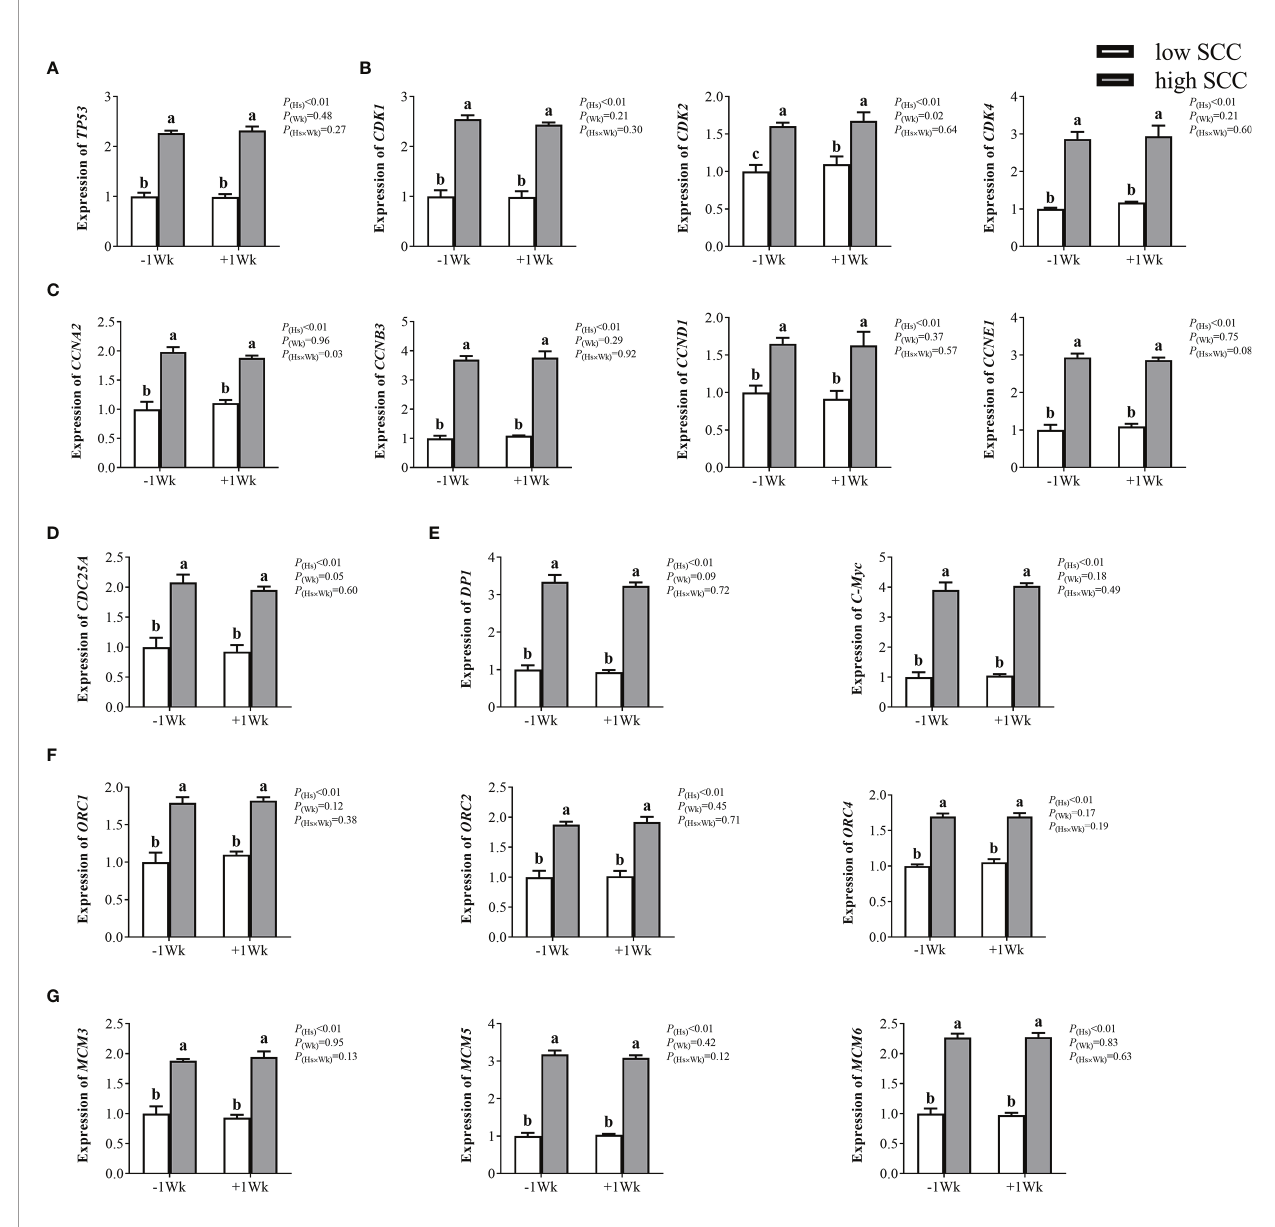
FIGURE 2 | The mRNA expression of genes involved in the cell cycle in neutrophils from dairy cows with low and high somatic cell counts (SCCs) at Week 1 pre- (-1 Wk) and postpartum (+1 Wk). (A) Neutrophil cell cycle reinitiation gene ( TP53 ). (B) Cyclin-dependent kinases ( CDK1 , CDK2 , CDK4 ). (C) Cyclin-dependent kinase speci fi c- substrates ( CCNA2 , CCNB3 , CCND1 , CCNE1 ). (D) Cyclin-dependent kinase upstream gene ( CDC25A ). (E) Cyclin-dependent kinase downstream genes. ( DP1 , C-Myc ) (F) DNA promoter-binding genes ( ORC1 , ORC2 , ORC4 ). (G) Initiation factors ( MCM3 , MCM5 , MCM6 ). The data are expressed as the mean ± SEM, n = 5 cows per group. Different superscripts (a, b, and c) represent signi fi cant differences ( P < 0.05). Hs, health status; Wk, sampling week; Hs × Wk, interaction between health status and sampling week. TP53 , tumor suppressor p53; CDK1 , cyclin-dependent kinase 1; CDK2 , cyclin-dependent kinase 2; CDK4 , cyclin-dependent kinase 4; CCNA2 , cyclin A2; CCNB3 , cyclin B3; CCND1 = cyclin D1; CCNE1 , cyclin E1; CDC25A , cell division cycle 25A; DP1 , D-prostanoid receptor 1; C-Myc , transcriptional regulator Myc-like; ORC1 , origin recognition complex subunit 1; ORC2 , origin recognition complex subunit 2; ORC4 , origin recognition complex subunit 4; MCM3 , minichromosome maintenance 3; MCM5 , minichromosome maintenance 5; MCM6 , minichromosome maintenance